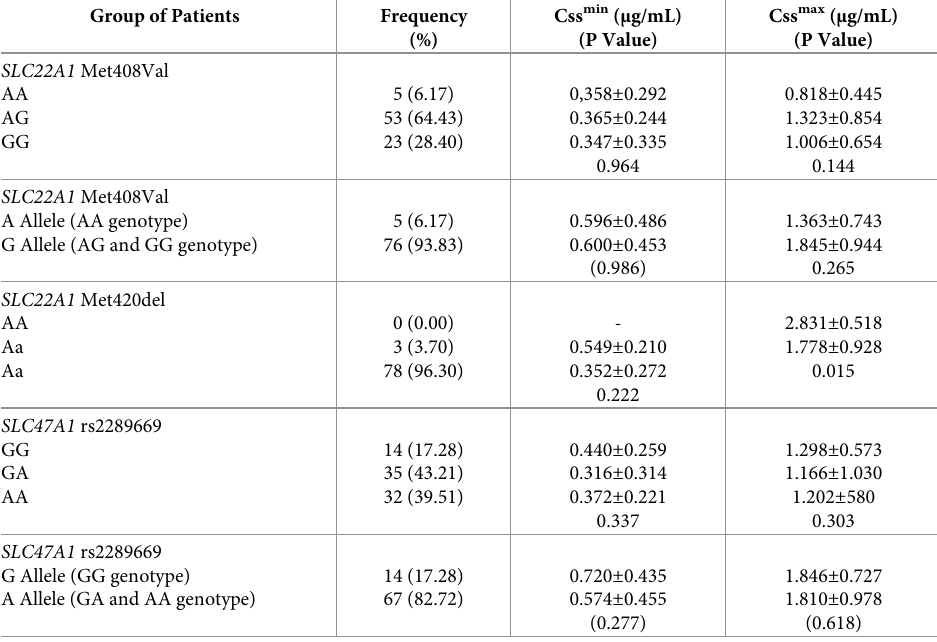
Table 1. Variability of metformin steady-state concentrations according to the genetic variants and alleles.